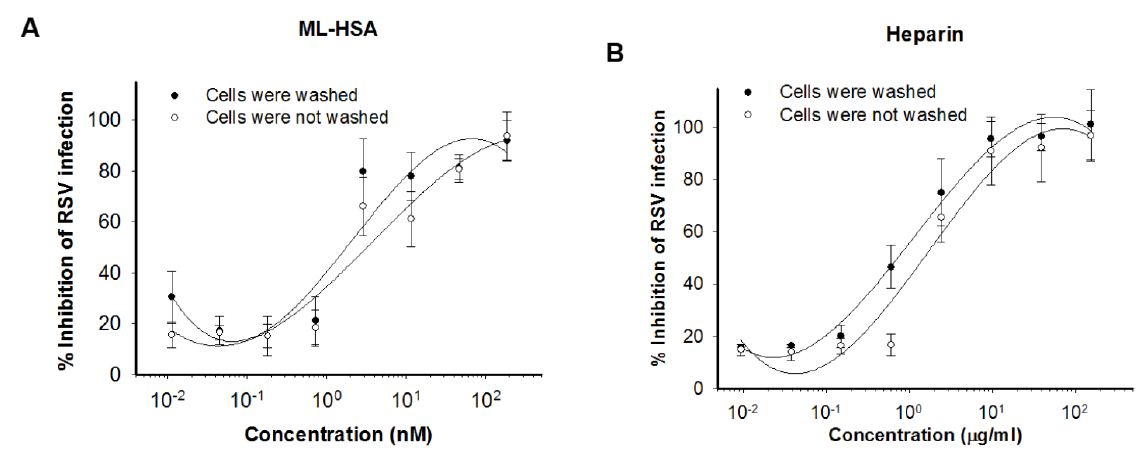
Figure 4. ML-HSA blocked RSV attachment. HEp-2 cells were incubated with RSV in the presence of serial dilutions of either ML-HSA ( A ) or heparin ( B ) at 4 °C for 1 h, followed by washes to remove unbound virus and inhibitor, or no washing before the temperature was shifted to 37 °C. CPE was determined after 5 days and plotted as cell viability. Each diluted sample was tested in triplicate, and the experiment was repeated twice. The data from one representative experiment were presented in mean ± SD.